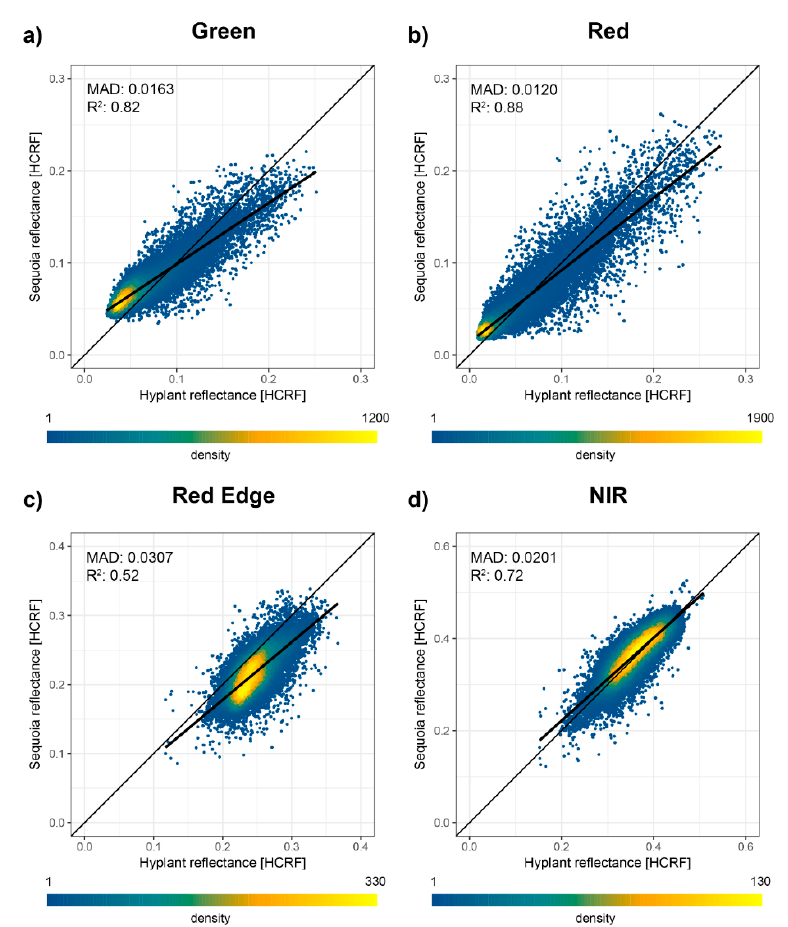
Figure 7. Scatterplot comparisons of Sequoia and HyPlant based HCRF values for the four bands analysed over the region of interest with an ordinary least squares regression line (bold), the R 2 and the MAD.